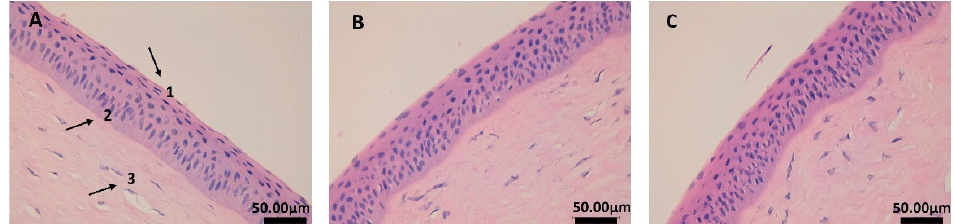
Figure 3. Corneal histological structure: ( A ) negative control (cornea without treatment); ( B ) cornea treated with PZ-NCs; ( C ) cornea treated with PZ-NCs dryer. 1: Stratified flat keratinized epithelium; 2: Bowman’s membrane; 3: own laminate. All images were observed at 400×.